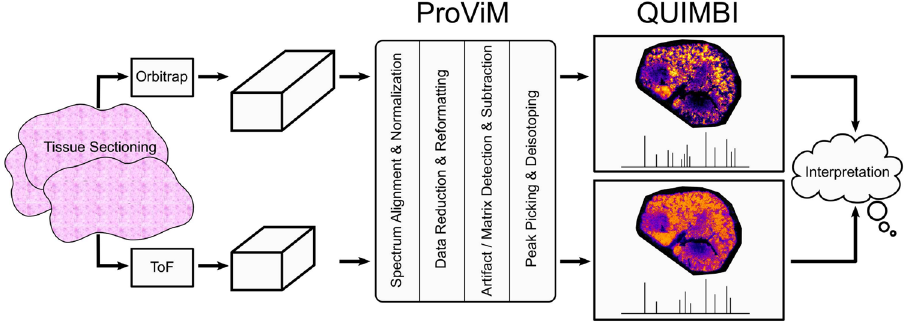
Figure 1. ProViM-QUIMBI workflow overview. After data set generation from either MALDI-ToF or MALDI- Orbitrap measurement ProViM successively executes four processing steps: (1) spectrum alignment and normalization, (2) data reduction and reformatting, (3) artifact and matrix detection and subtraction and (4) peak picking and deisotoping. Afterwards, the processed data set is interactively explored in